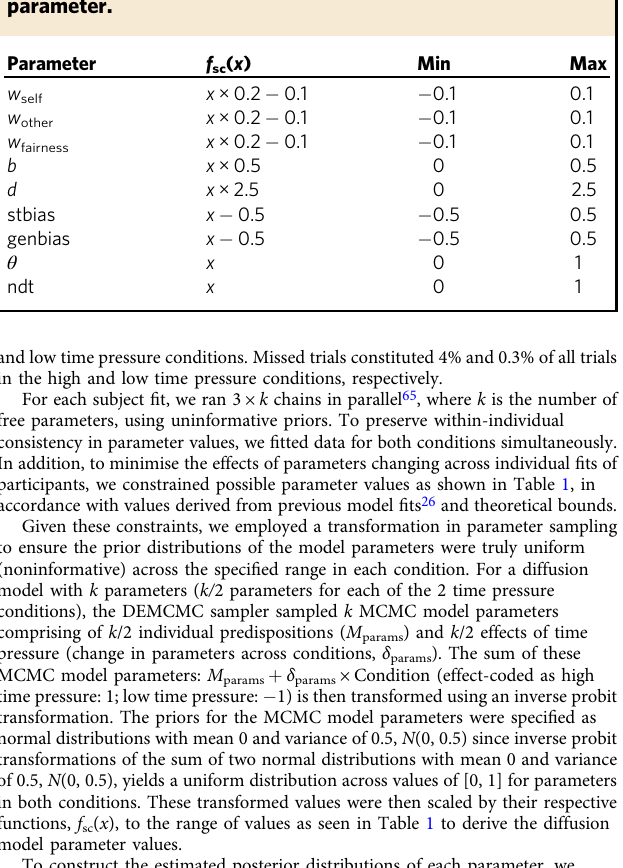
Table 1 Scaling function, f sc ( x ), for each diffusion model